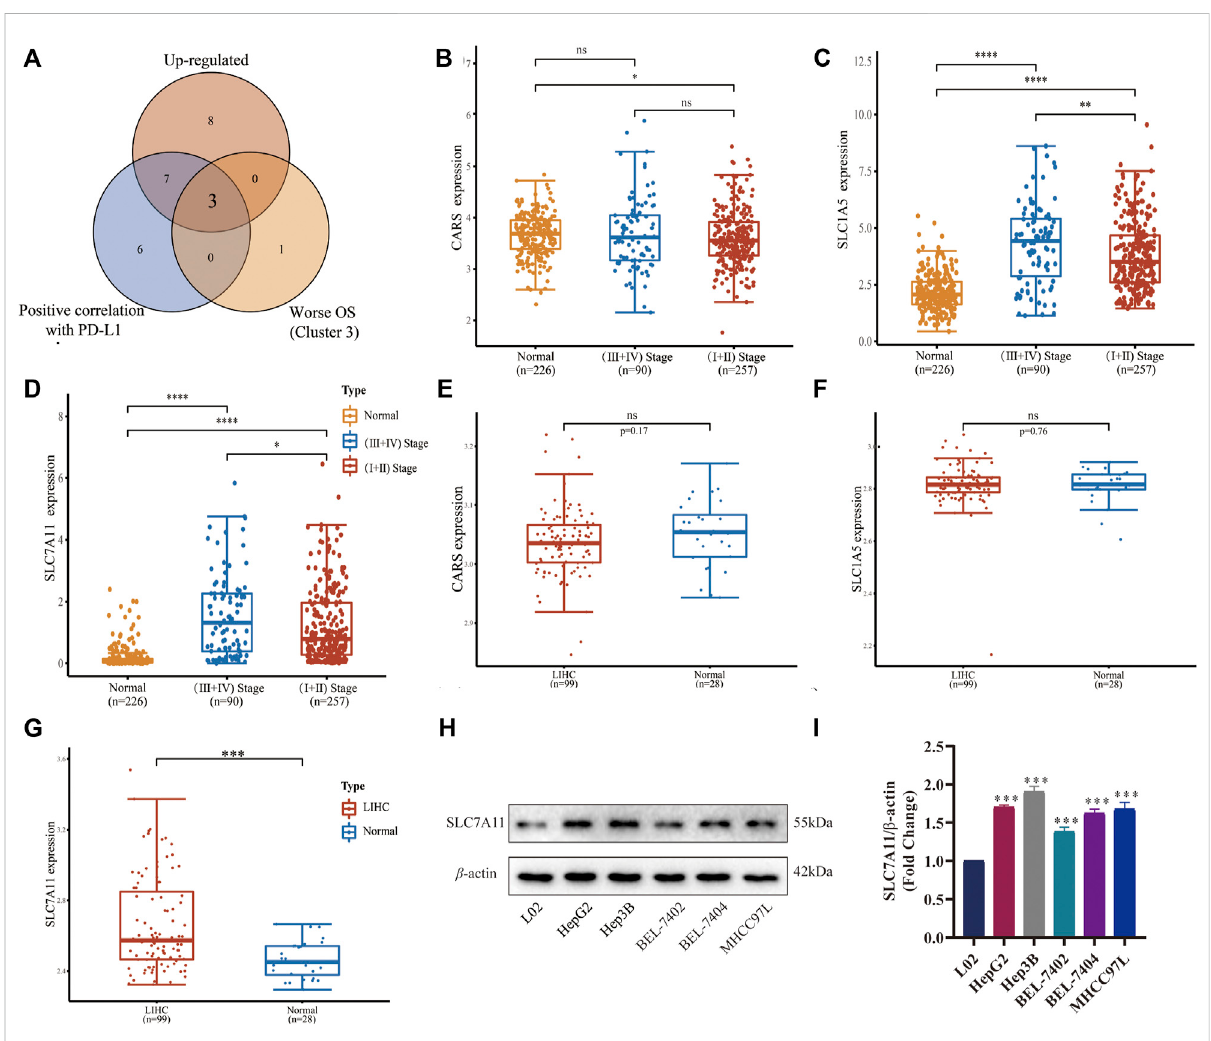
FIGURE 4 Expression and veri fi cation of a key ferroptosis regulator SLC7A11 in LIHC. (A) Venn diagram identi fi ed three upregulated FRGs associated with PD-L1 and worse prognoses. (B – D) Differential expression of CARS, SLC1A5, and SLC7A11 in different stages of tumor group and normal group in GSE60502. (E – G) Differential expression of CARS, SLC1A5, and SLC7A11 in the tumor group and normal group in GSE62232. (H) The expressions of SLC7A11 in differentcell lines weredetected byWesternblot( n =3). (I) Histogram ofdifferential SLC7A11 expressionon fi veLIHC celllines. * p < 0.05, ** p < 0.01, *** p < 0.001 and **** p <